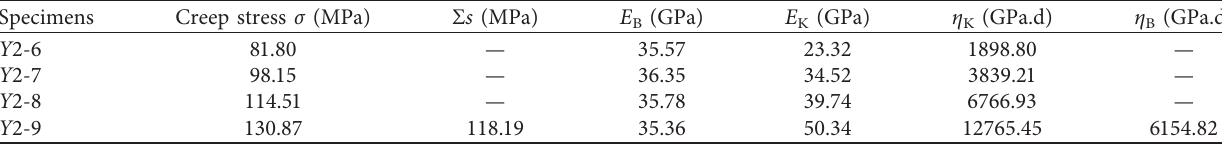
Table 4: Calculation values of creep parameters of the iron